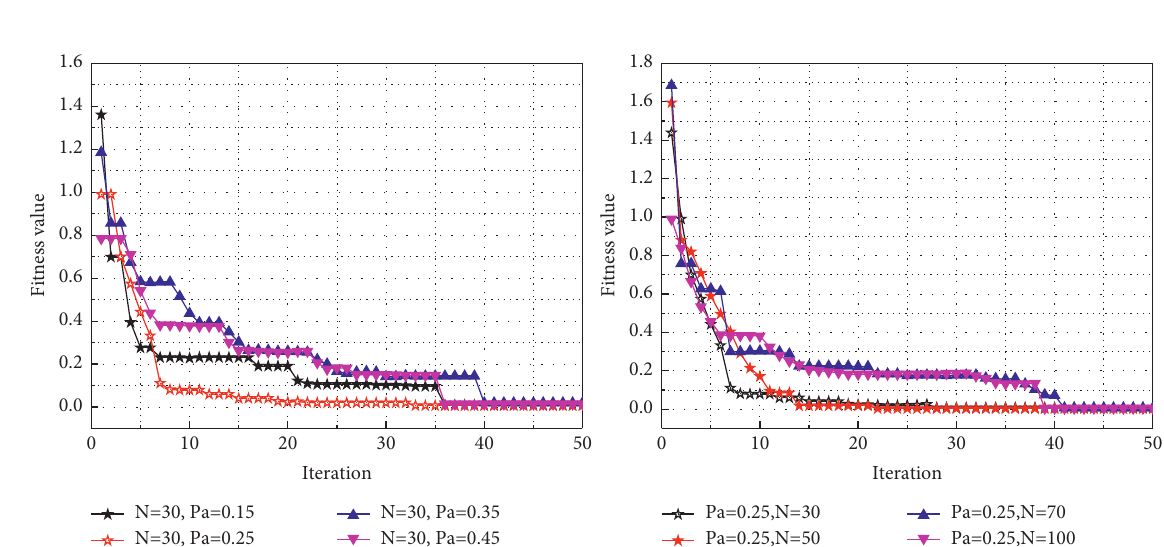
Figure 11: Iterative convergence curves under different Pa and